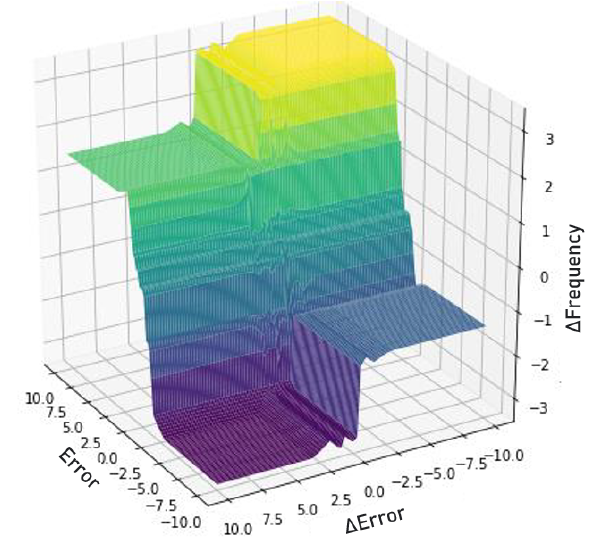
Figure 21. Generated fuzzy surface. Source: